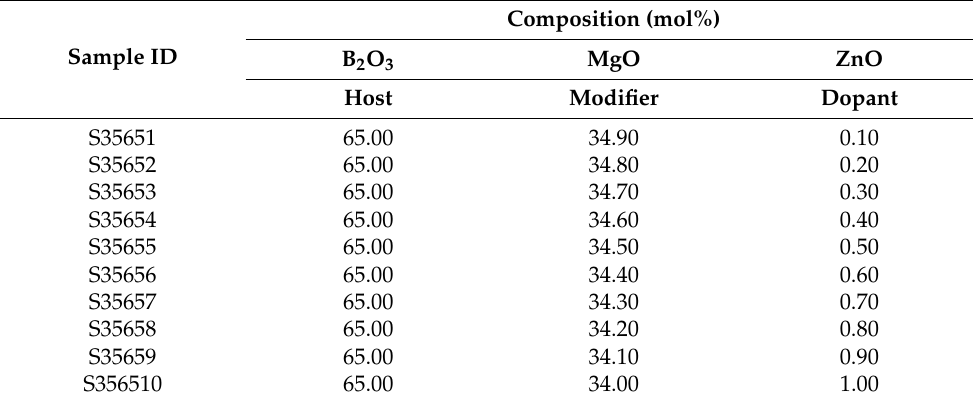
Table 1. Composition of synthesized